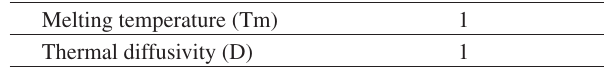
Table 1. Material properties 2 .